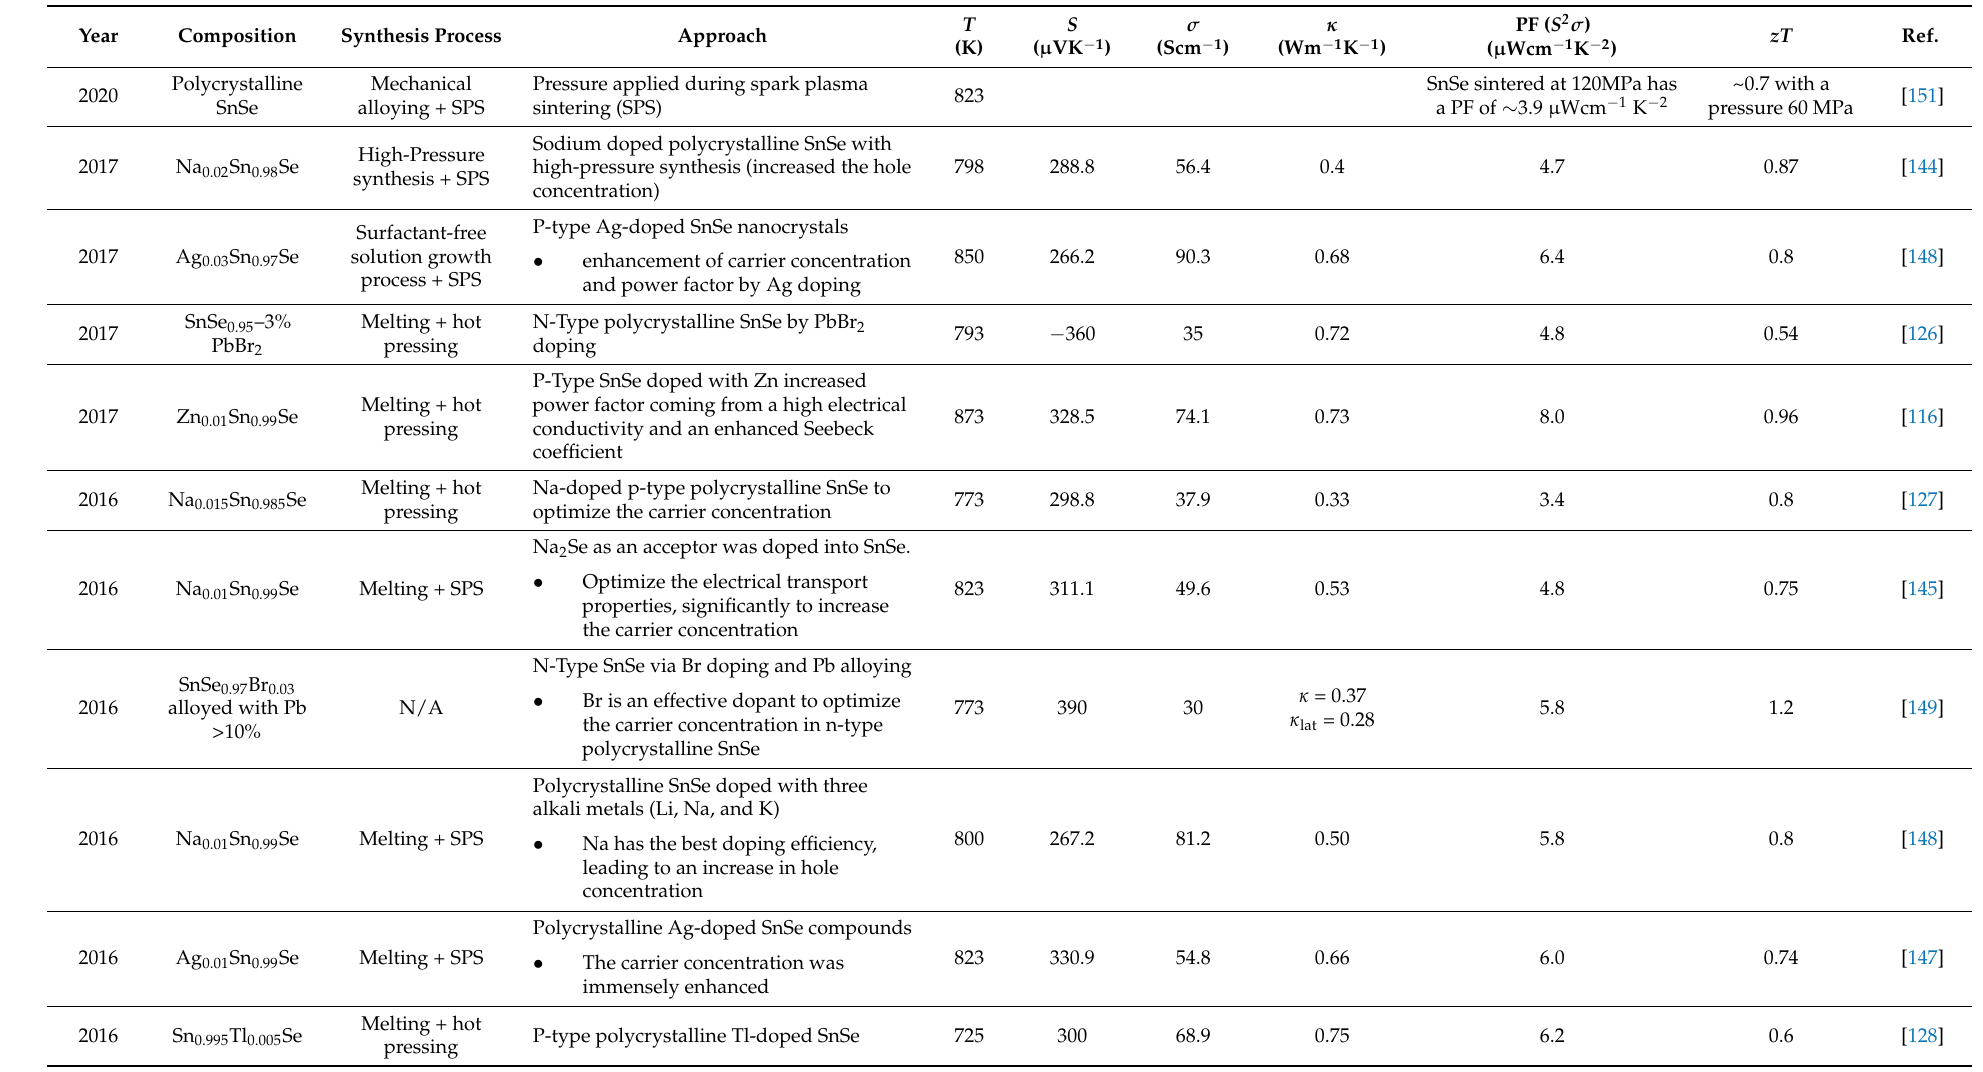
Table 3. TE properties and synthesis of SnSe with enhancement of power factor